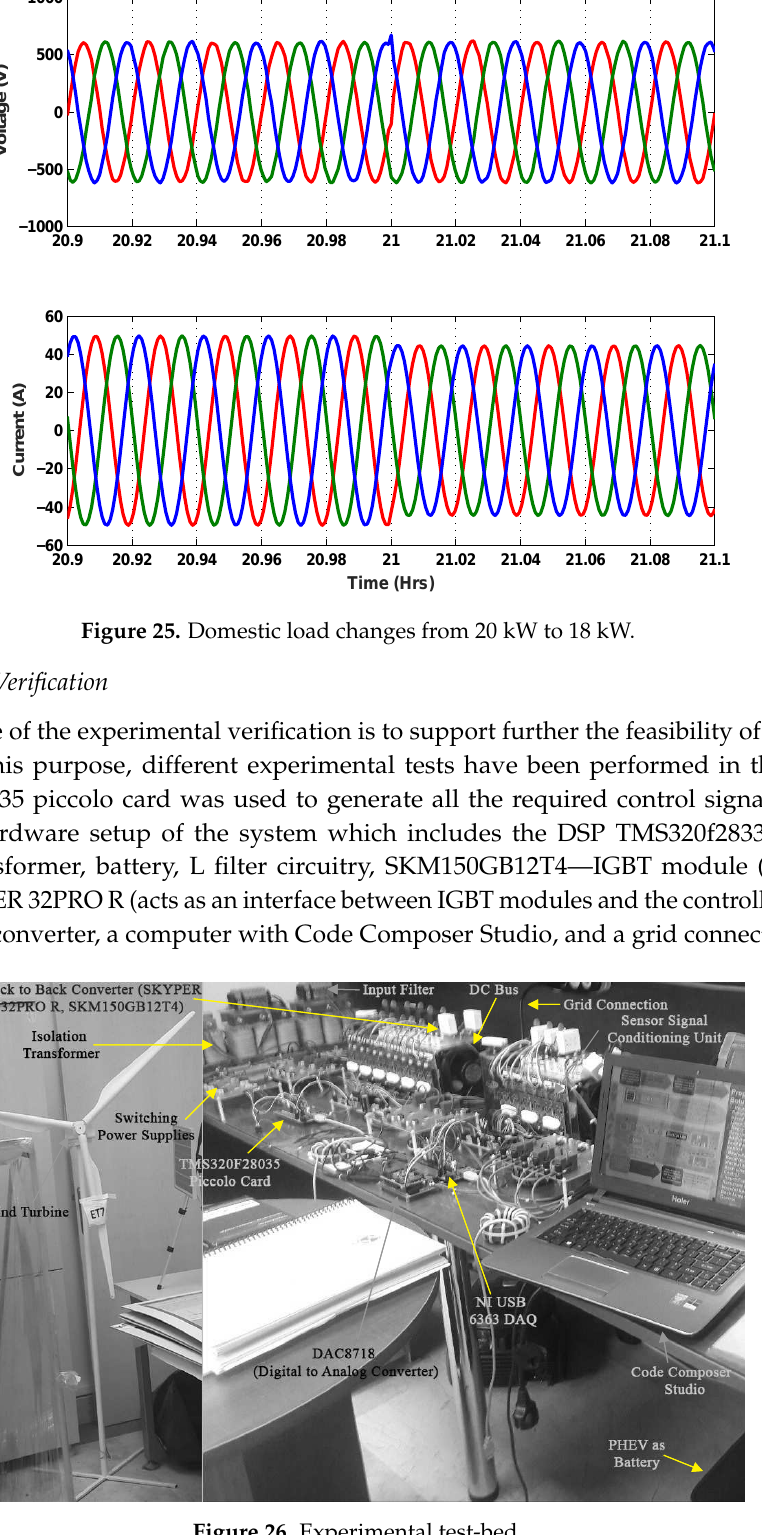
Figure 26. Experimental